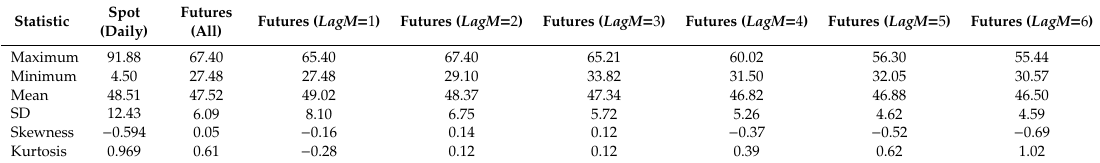
Table 1. Training period prices (€/MWh).